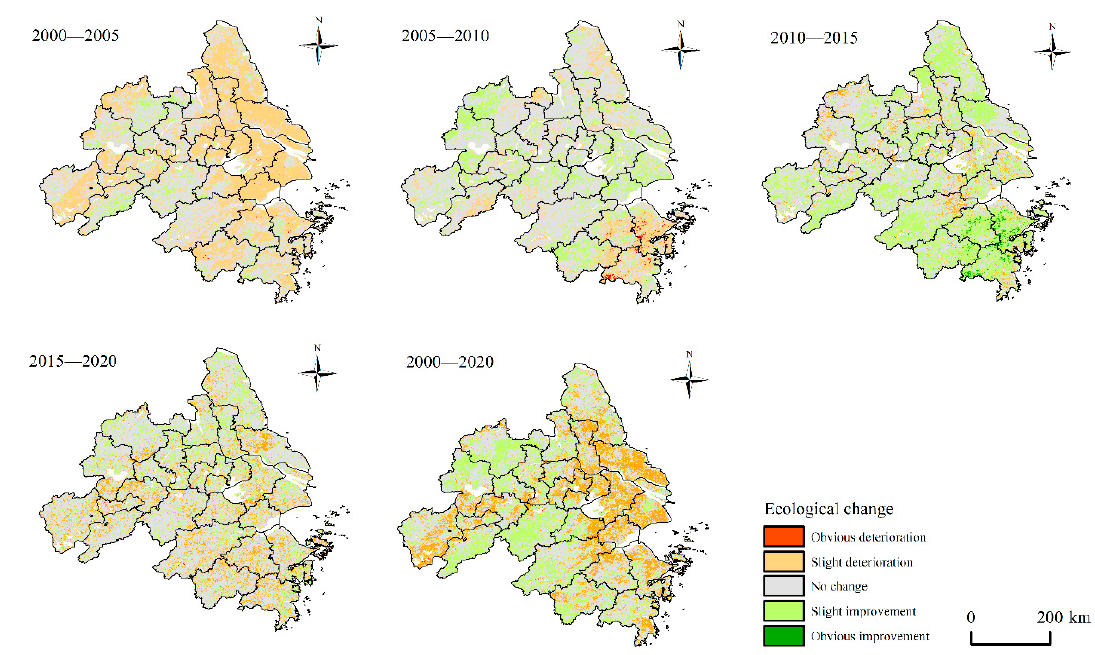
Figure 4. Changes of ecological environment level in the YRDUA from 2000 to 2020.